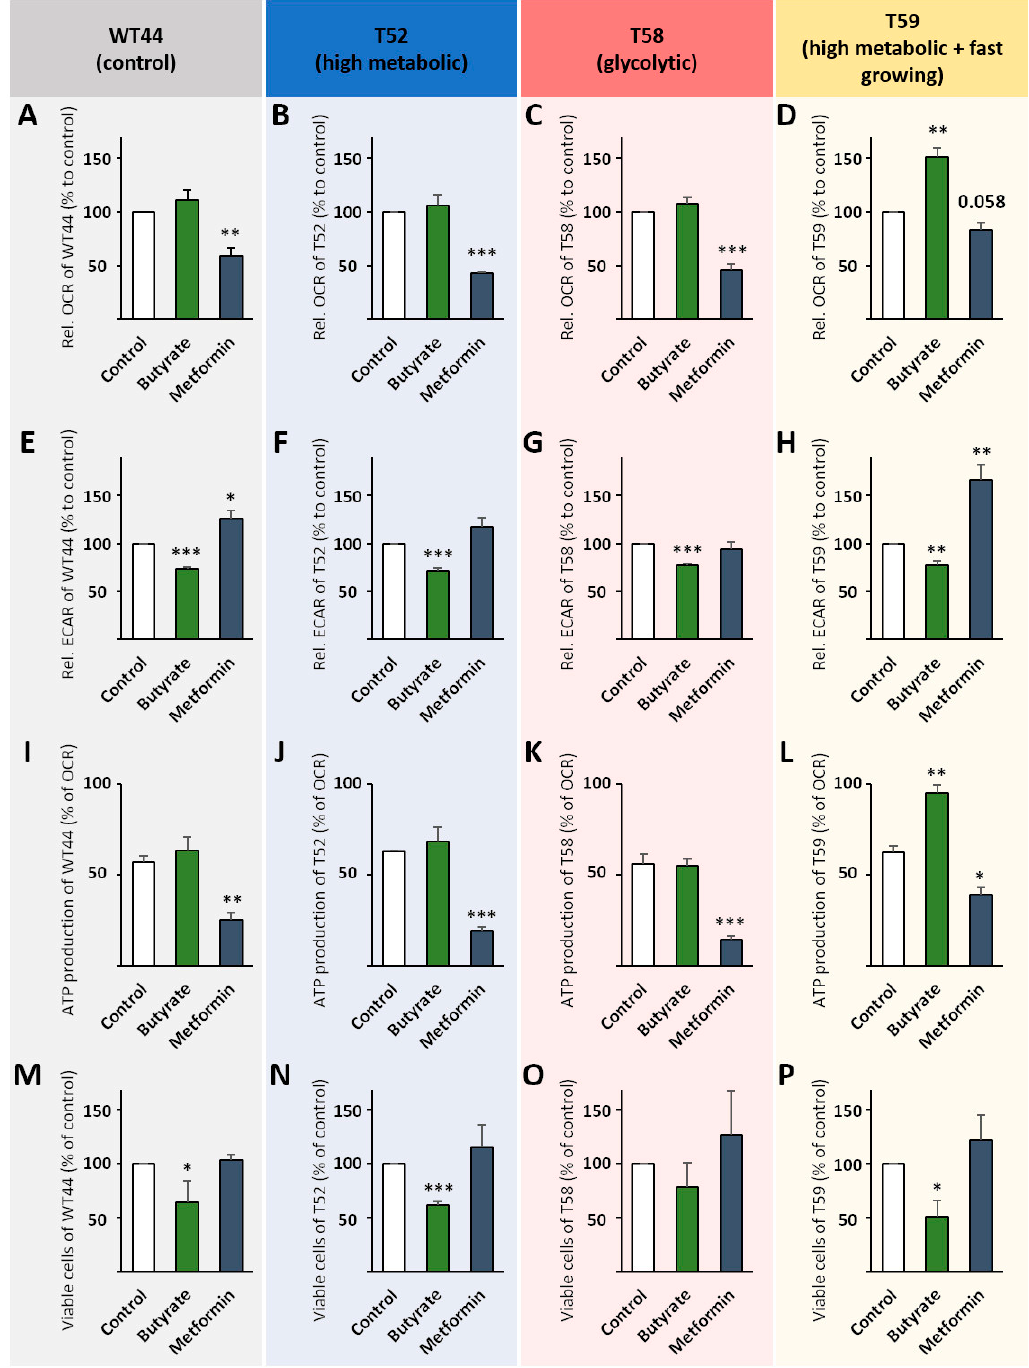
Figure 4. Metabolic changes after metformin and butyrate treatment. Cell clones were seeded in 24-well Agilent Seahorse XF Cell Culture Microplates, then treated with 1 mM butyrate or 1 mM metformin for 24 h followed by a Cell Mito Stress Test using a Seahorse XFe24 Analyzer. Mitochondrial ATP production and basal respiration were calculated from OCRs for WT44 ( A , I ), T52 ( B , J ), T58 ( C , K ), and T59 ( D , L ). Basal ECARs are shown for WT44 ( E ), T52 ( F ), T58 ( G ), and T59 ( H ). The number of viable cells was determined after 24 h of treatment with butyrate or metformin with a ViCell XR cell counter using trypan blue for the clones WT44 ( M ), T52 ( N ), T58 ( O ), and T59 ( P ). All values are shown relative to the untreated controls of each cell clone as the mean + SEM for the Seahorse measurements or as the mean + SD for cell numbers from three or four biological replicates. Statistical differences were calculated via a two-sided t -test for the Seahorse measurements or a one-way ANOVA following a Bonferroni or Dunnett-T3 post hoc test for the viable cells with * p < 0.05, ** p < 0.01, and *** p < 0.001 vs. untreated control